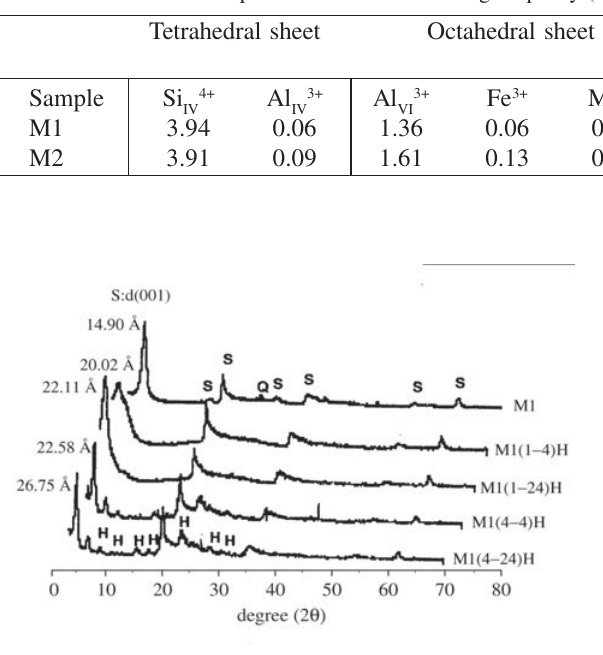
Table 1. Half unit-cell composition and cation exchange capacity (CEC) of montmorillonites 19 .